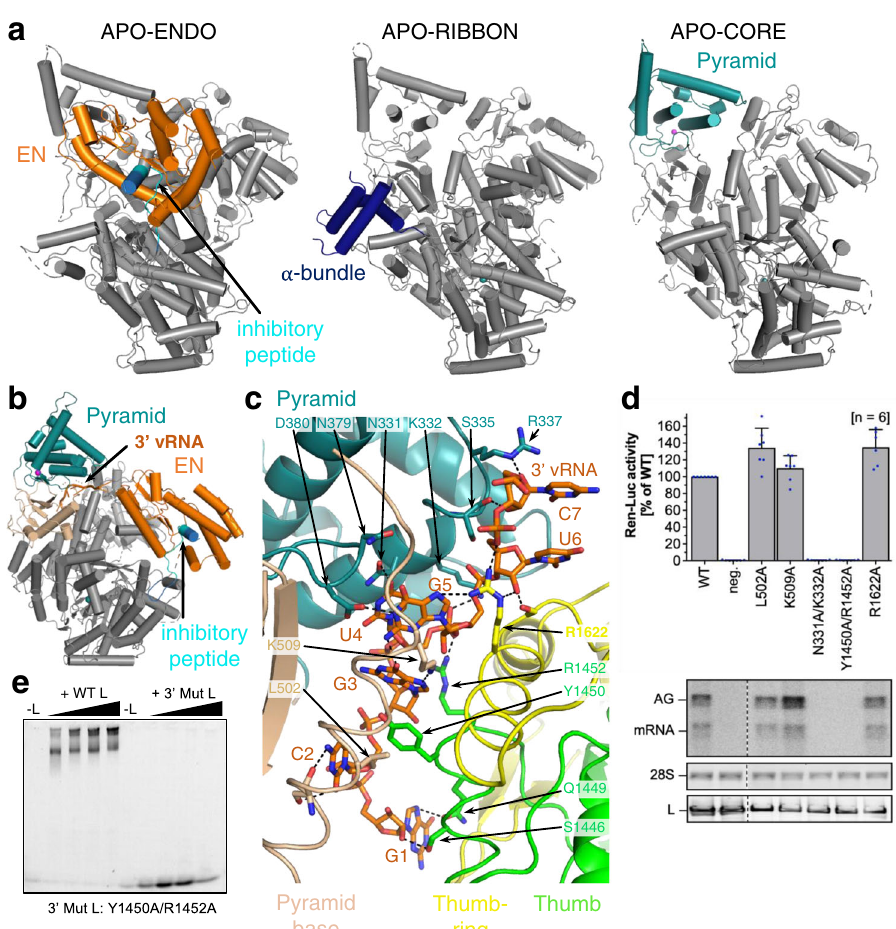
Fig. 1 L protein in the apo-state and with 3 ′ viral RNA bound in the secondary binding site. a Ribbon diagram presentations of the structures APO-ENDO, APO-RIBBON and APO-CORE. Each of the respective experimental maps resolves distinct regions of the L protein better than the others and those regions are shown in colour and indicated by name in the respective structures. b Overall structure of L protein 3END-CORE as a ribbon diagram with the 3 ′ vRNA bound below the pyramid domain. Pyramid (teal), pyramid base (wheat), EN domain (orange) and the inhibitory peptide (cyan) are highlighted. c Close-up of the secondary 3 ′ vRNA binding site with the 3 ′ vRNA nucleotides 1 – 7 (orange), pyramid domain (teal), pyramid base (wheat) as well as thumb (green) and thumb-ring (yellow) domains. Important amino acids in the RNA-protein interface are shown as sticks with respective labels. Hydrogen bonds are indicated by dotted lines. For selected regions, secondary structure depiction was disabled to enhance visibility. d LASV mini-replicon data for L proteins with mutations in the secondary 3 ′ RNA binding site presenting luciferase reporter activity (in standardised relative light units relative to the wild-type L protein (WT)). Data were presented as mean values± SD of at least six biological replicates ( n = 6), although for most mutants seven biological replicates were included. All biological replicates are shown as blue dots (top panel). Middle panels present Northern blotting results with signals for antigenomic viral RNA (AG), viral mRNA (mRNA) and 28 S ribosomal RNA (28 S) as a loading control, and the bottom panel shows Western blot detection of FLAG- tagged L proteins (L) to demonstrate general expressibility of the mutants. Source data are provided in a Source Data fi le. e Electrophoretic mobility shift assay of wild-type L protein (WT L) and mutant Y1450A/R1452A (Mut L) with 10 nt 3 ′ viral RNA. L protein concentrations ranging from 0 – 1 µ M and 0.2 µ M of fl uorescently labelled 3 ′ vRNA (Supplementary Table 1) were used (see (Fig. 1c). This site corresponds to the secondary 3 ′ end-binding site previously described for in fl uenza virus, La Crosse virus (LACV) and MACV polymerase proteins 9,13,16 – 18 . In these structures, the EN remains in the inhibited conformation as observed in the APO-ENDO structure (compare Fig. 1a and b).